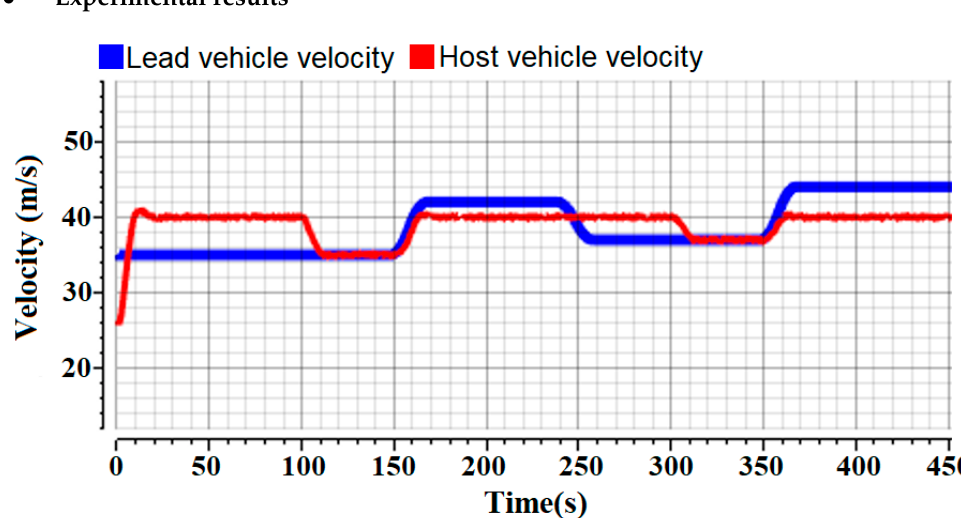
Figure 21. Velocity of the leading vehicle and host vehicle (experimental results).